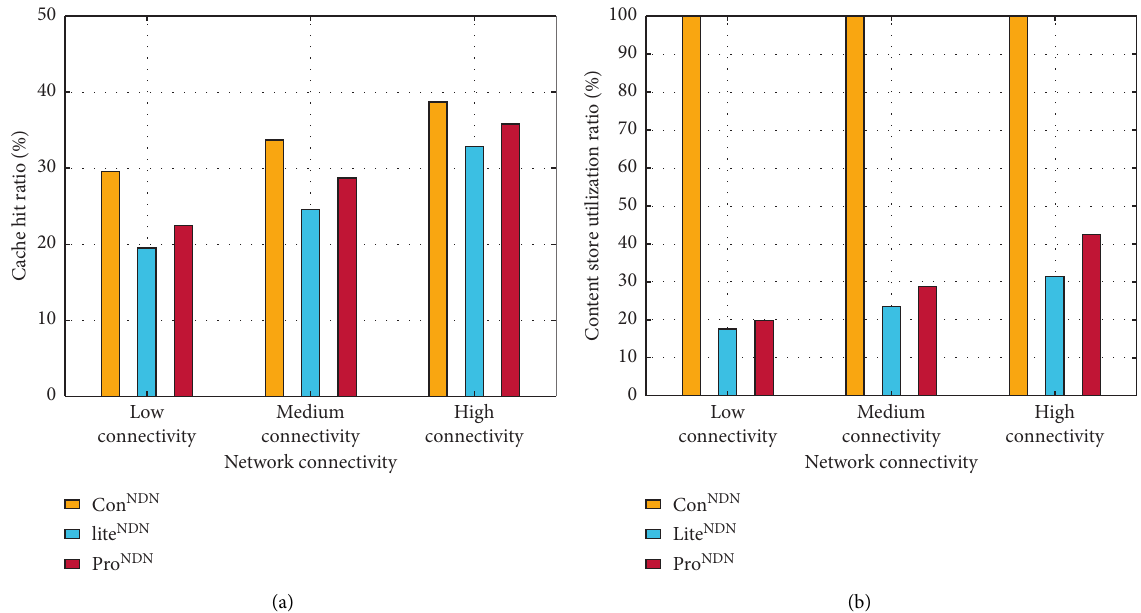
Figure 9: The performance of cache hit ratio and Content Store utilization ratio against network